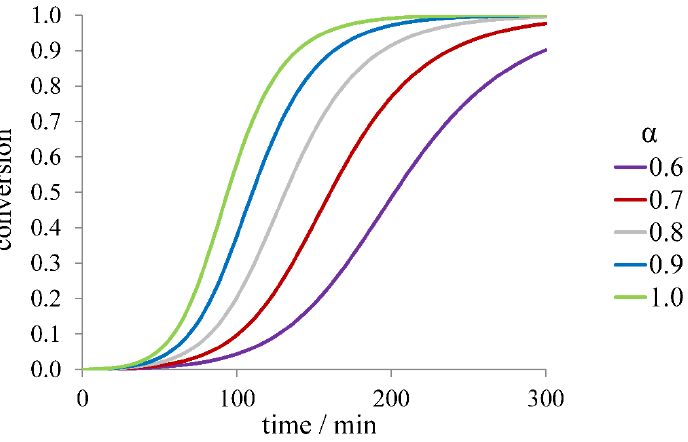
Figure 5. Dependence of the fibril formation time course on the fraction of aggregation-capable protein form ( α ) for the model with secondary nucleation and no fragmentation.